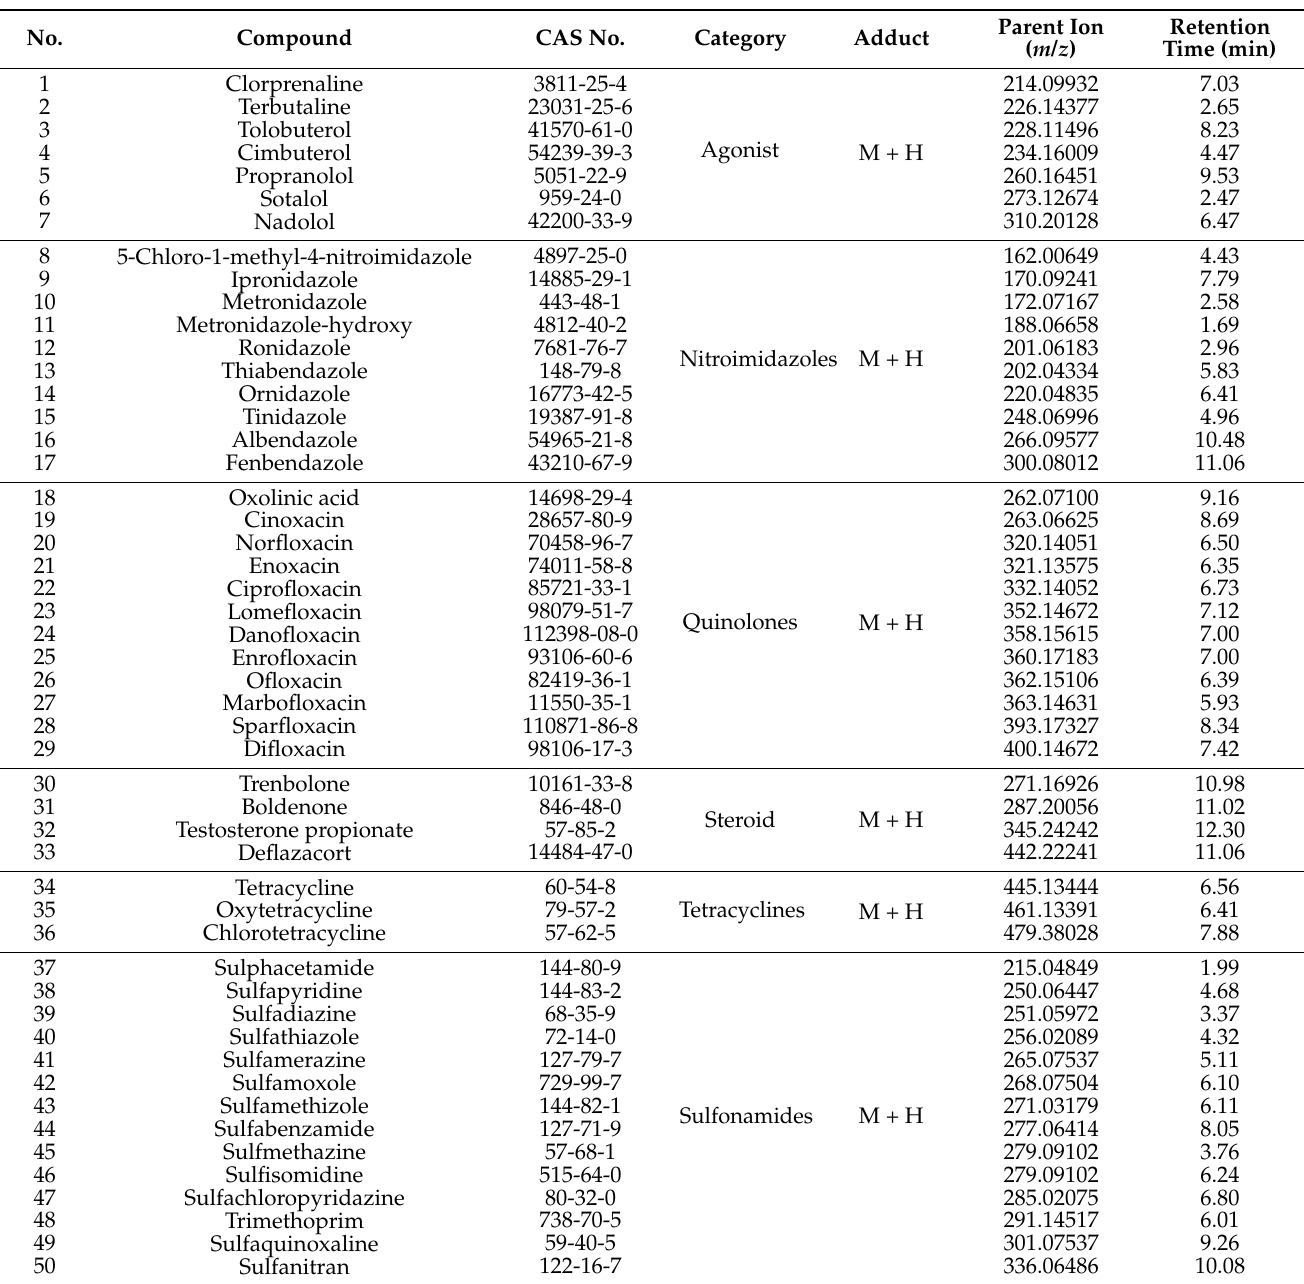
Table 1. Basic information on the 50